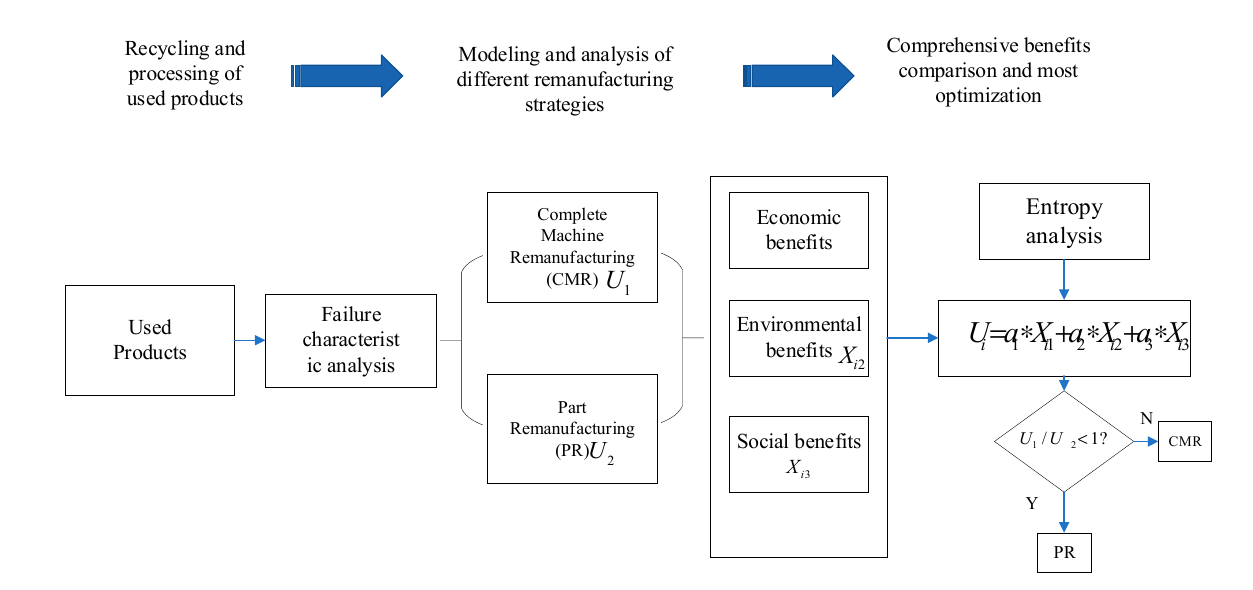
Figure 1. Flow chart of remanufacturing strategies decision-making.